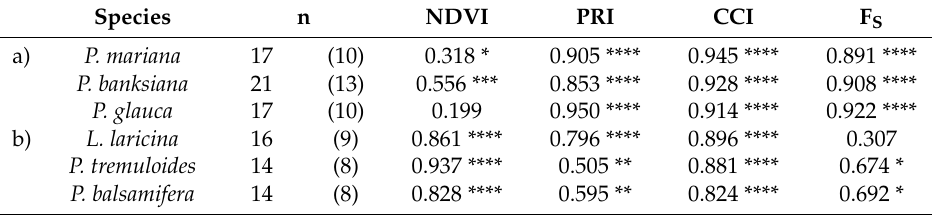
Table 1. Linear correlation coefficients ( r 2 ) between canopy-level optical indices (normalized difference vegetation index (NDVI), photochemical reflectance index (PRI), chlorophyll/carotenoid index (CCI), and steady-state fluorescence (Fs)) and photosynthetic rate for evergreen ( a ) and deciduous ( b )